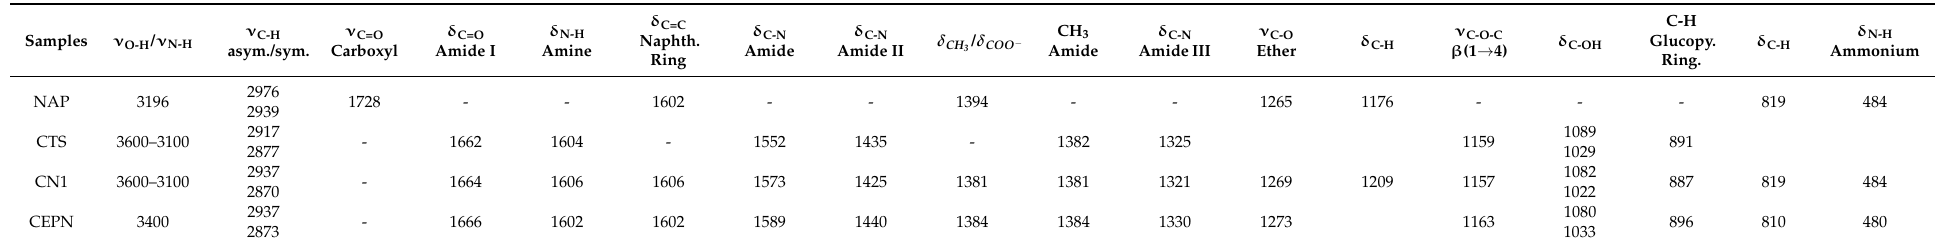
Table 4. Assignment of the bands observed in the FTIR spectra of NAP, CTS, CN1 and